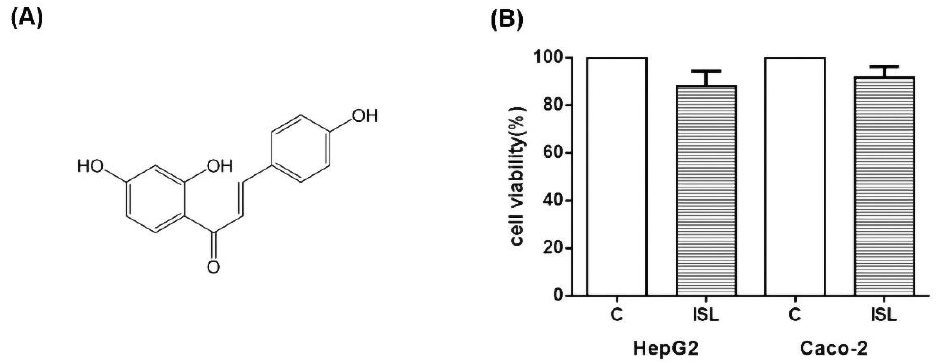
Figure 9. ( A ) Diagram of ISL molecular structure. ( B ) Effect of 100 µ M ISL on cell viability. 100 µ M ISL had a minimal effect on cell viability. The viability of HepG2 cells was approximately 87%, and that of Caco-2 cells was approximately 93%. Experiments were performed in triplicate and expressed as mean ± standard deviation.